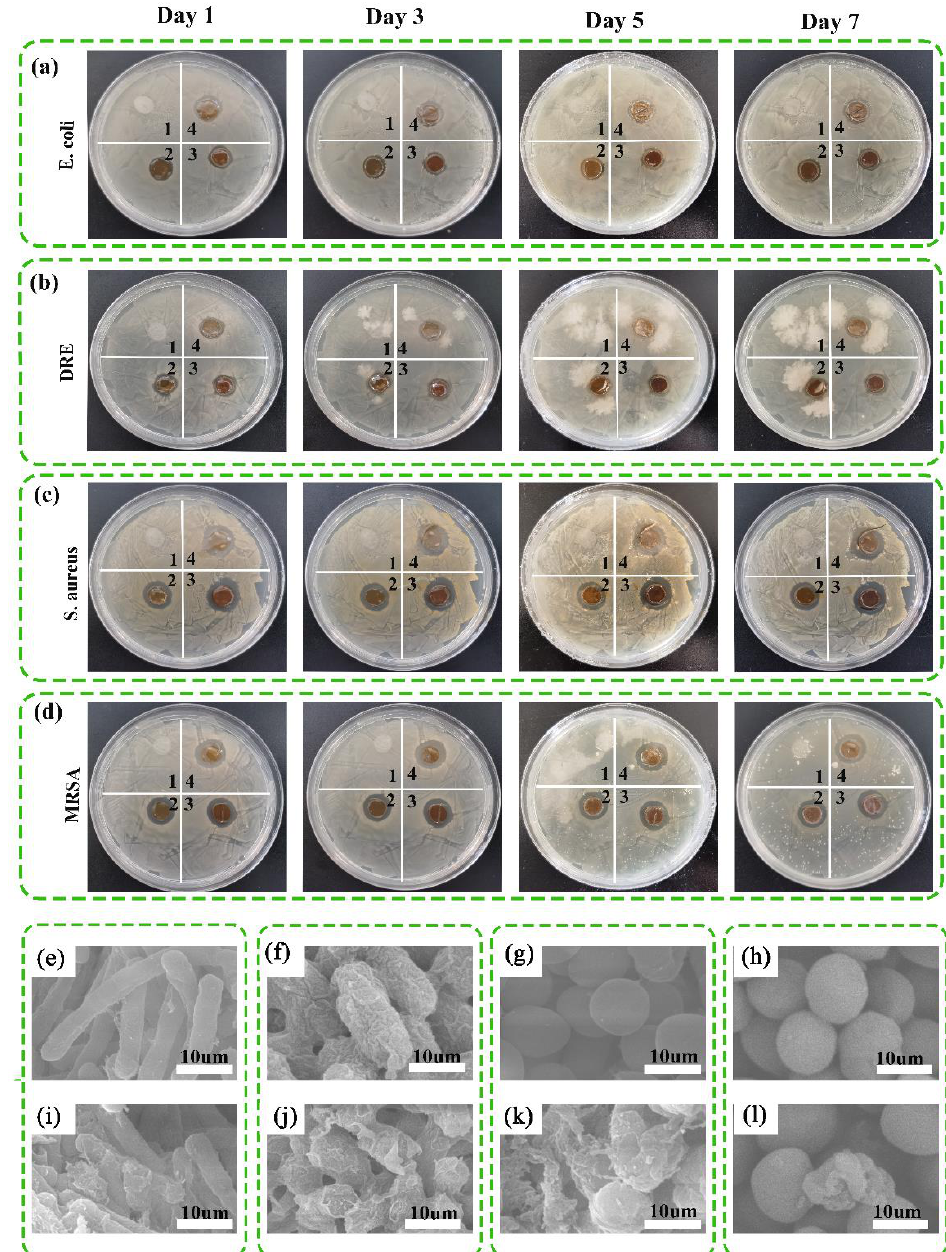
Figure 6. Pictures of the inhibition zones for bacterial from the sterilizing effectiveness test for ( a ) E. coli , ( b ) DRE , ( c ) S. aureus , and ( d ) MRSA ; (1) CS/SS, (2) CS/SS/Ag@MOF, (3) CS/SS/GO, and (4) CS/SS/Ag@MOF–GO. SEM images of intact and damaged E. coli ( e , i ), DRE ( f , j ), S. aureus ( g , k ), and MRSA ( h , l ).